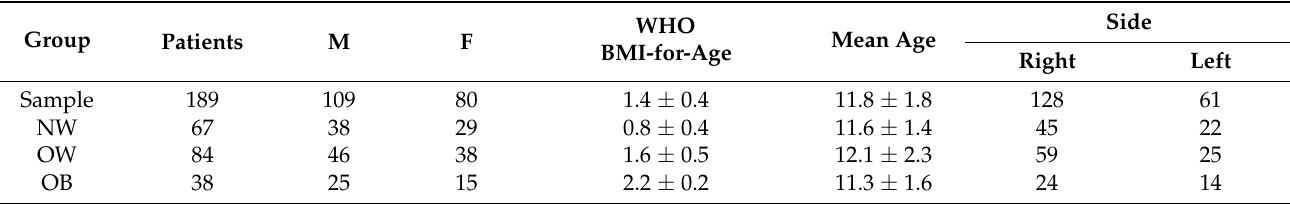
Table 1. Patients’